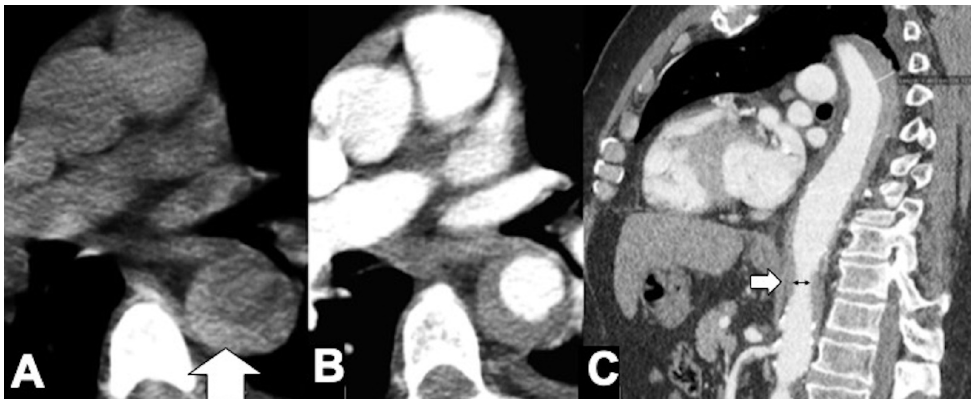
Figure 8. CT features of acute type B IMH in a 62-year-old man with abrupt chest pain and Type B IMH at baseline CTA examination. ( A ) Axial low-dose unenhanced CT image shows hyperdense crescent sign of the aortic wall (arrow). ( B ) Axial arterial phase CTA image in the same patient shows decreased diameter of the aortic lumen and the smooth luminal-wall interface. ( C ) Sagittal reconstruction CTA image shows decreased diameter of the aortic lumen (arrow) and a relative constant circumferential relationship with the wall. Table 5. MDCT and clinical features suggesting risk of progression of IMH.